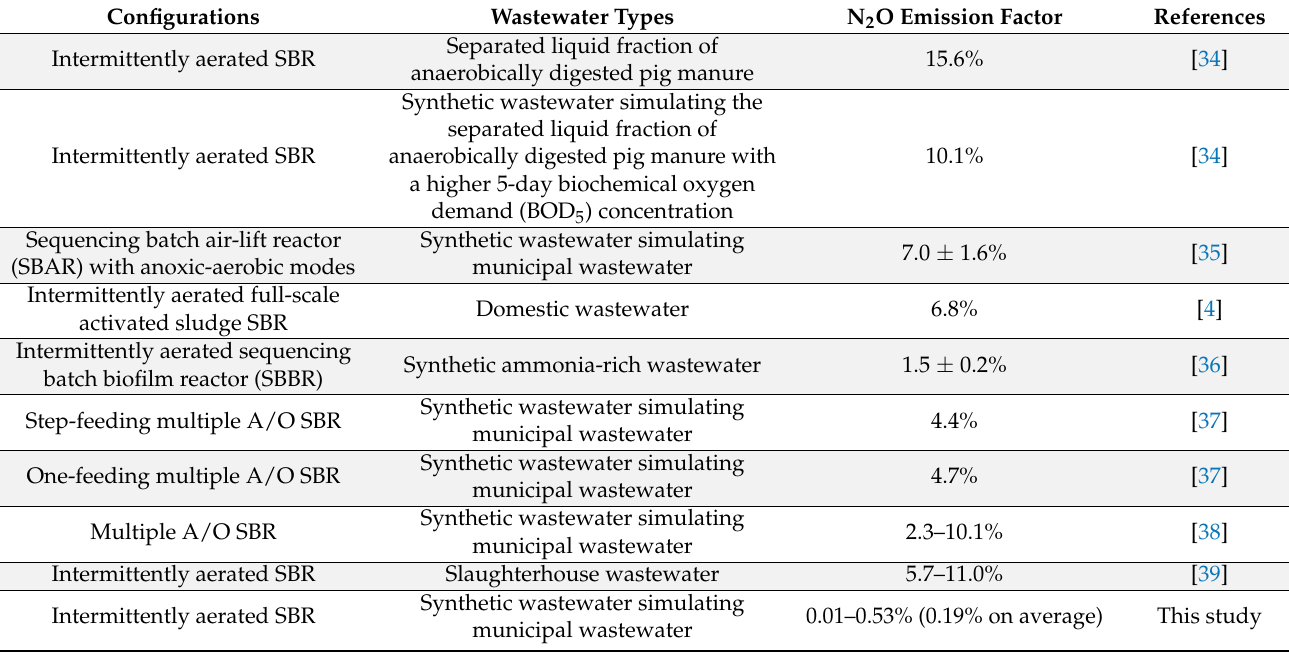
Table 1. N 2 O-emission factors in various intermittently aerated